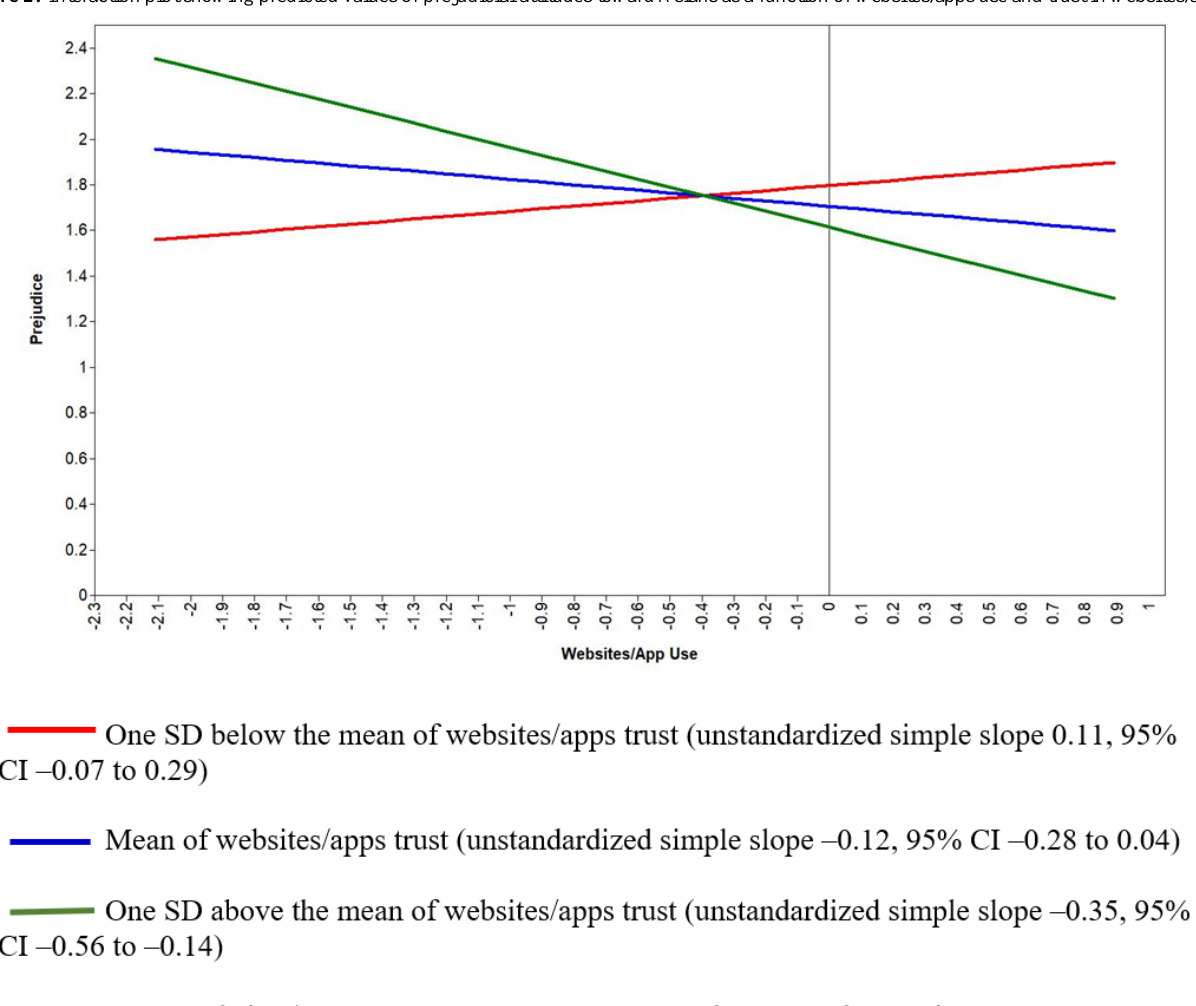
Figure 2. Interaction plot showing predicted values of prejudicial attitudes toward Asians as a function of websites/apps use and trust in